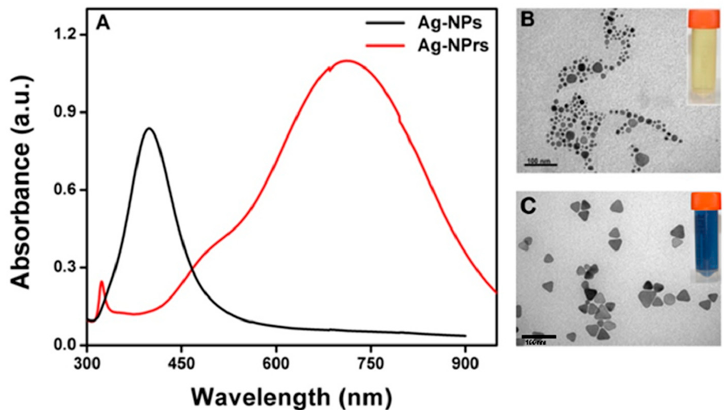
Figure 7. UV-vis spectra of Ag-NPs and Ag-NPrs ( A ) and TEM images are showing that both Ag-NPs with spherical shapes can be converted to Ag-NPrs at room temperature and open-air conditions ( B , C ).